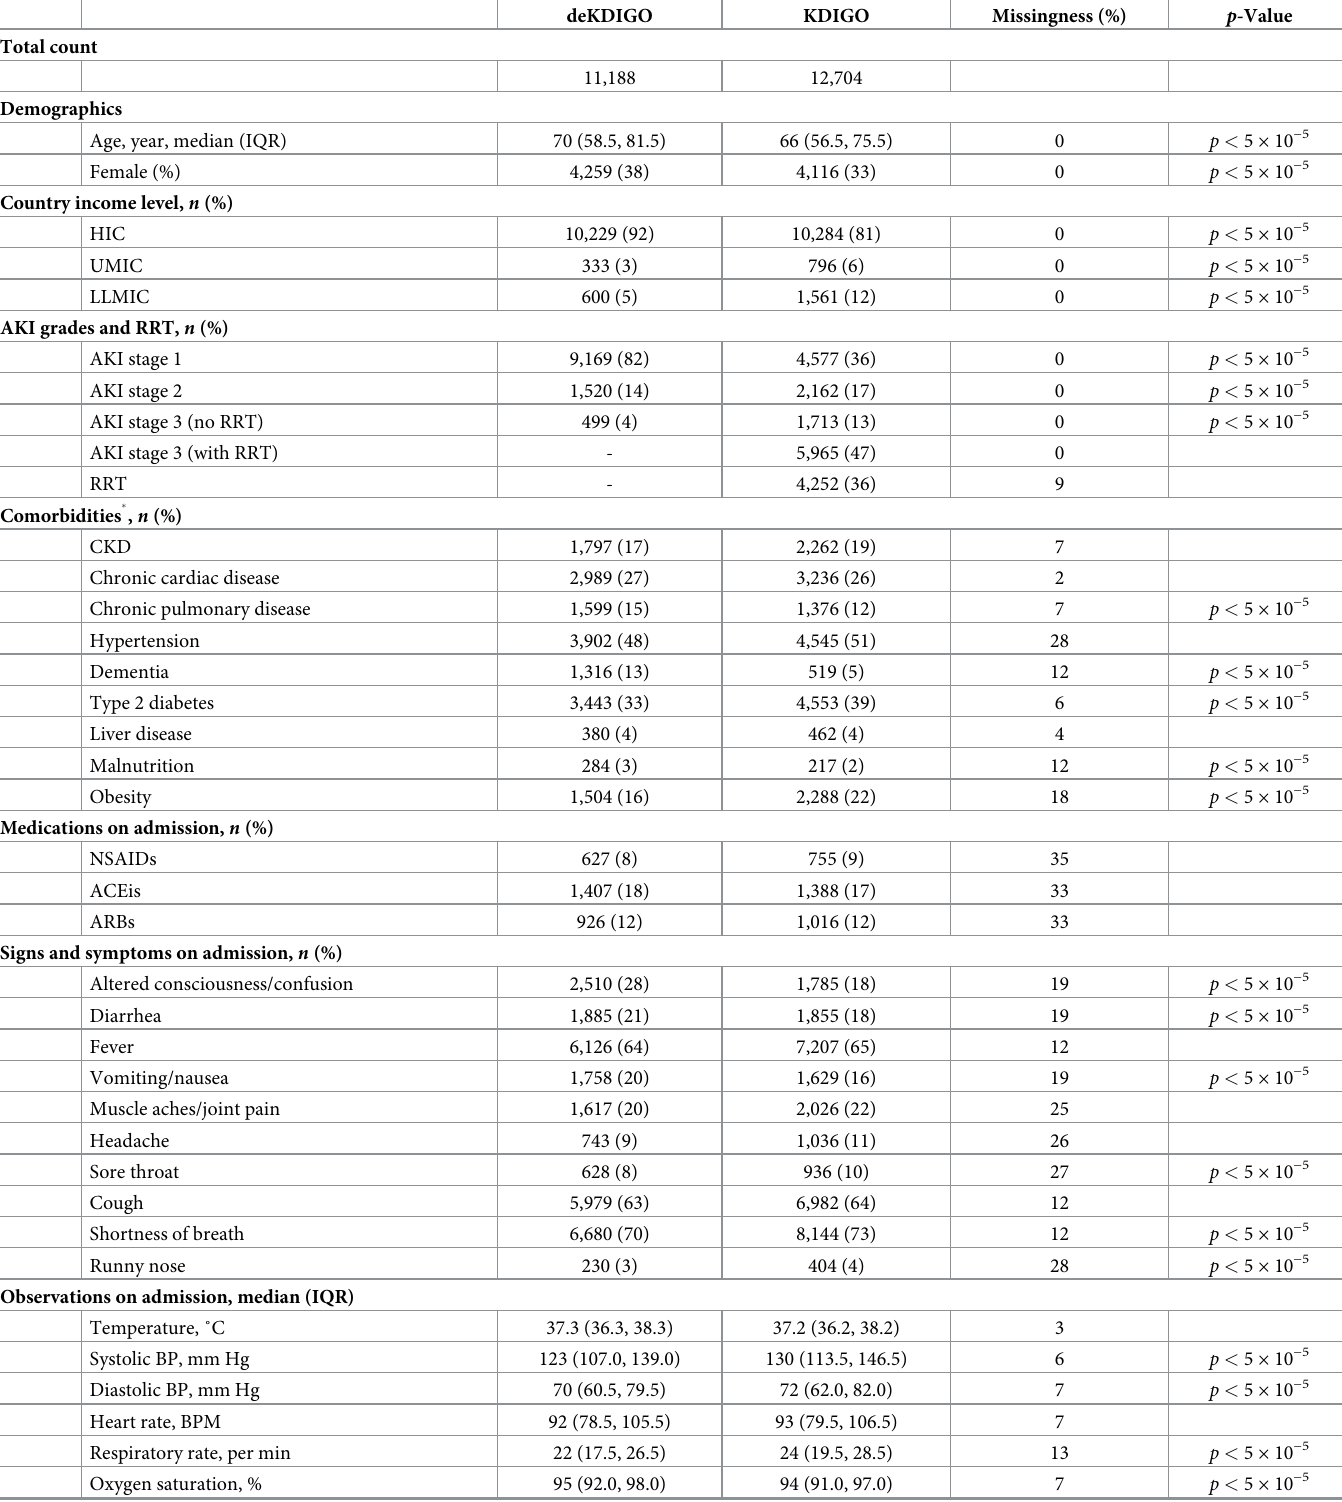
Table 3. Characteristics of patients with AKI diagnosed using KDIGO definition versus patients diagnosed with AKI by eKDIGO only by the decrease in sCr